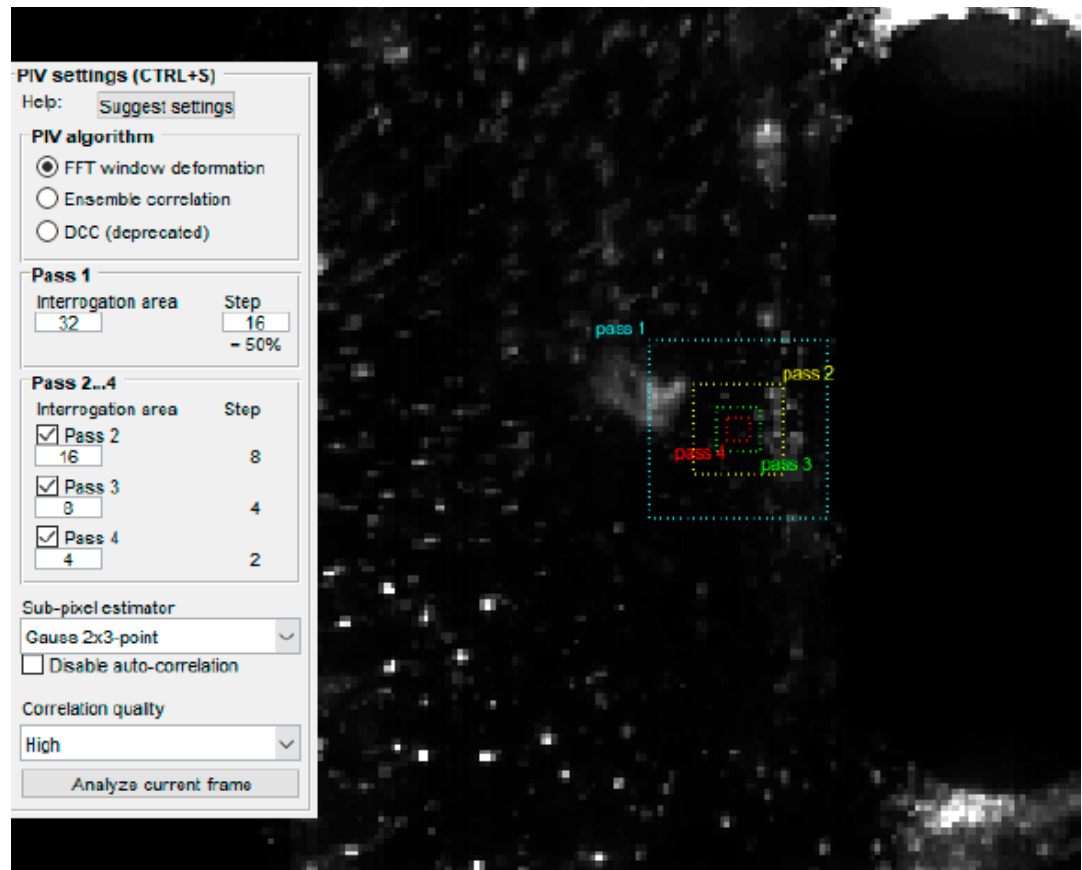
Figure 5. Windows of each pass in the TCPC ‐ 3 image with particle image velocimetry (PIV) settings.